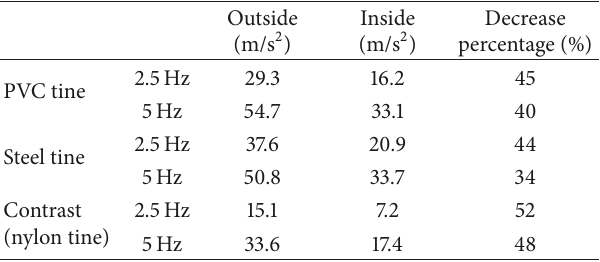
Table 5: The average decrease percentage of the median of acceler- ation